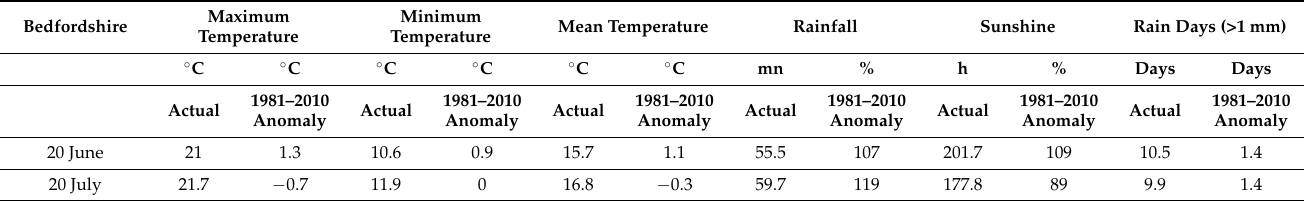
Table 2. Climatology for Bedfordshire compiled by the “National Climatological Information Centre (NCIC) at the Met Office”, from the surface observation network.